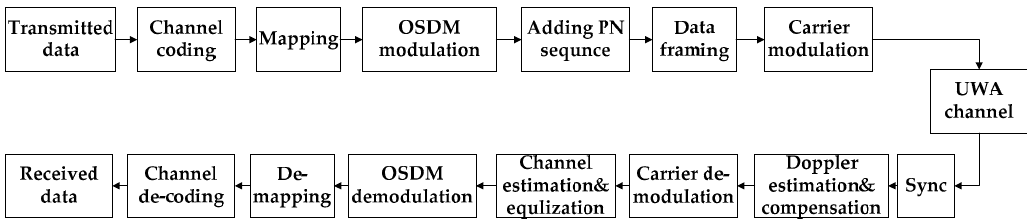
Figure 1. System structure of pseudo-noise sequence-based underwater acoustic orthogonal signal division multiplex (OSDM) communication system (UWAOSDM/PN).